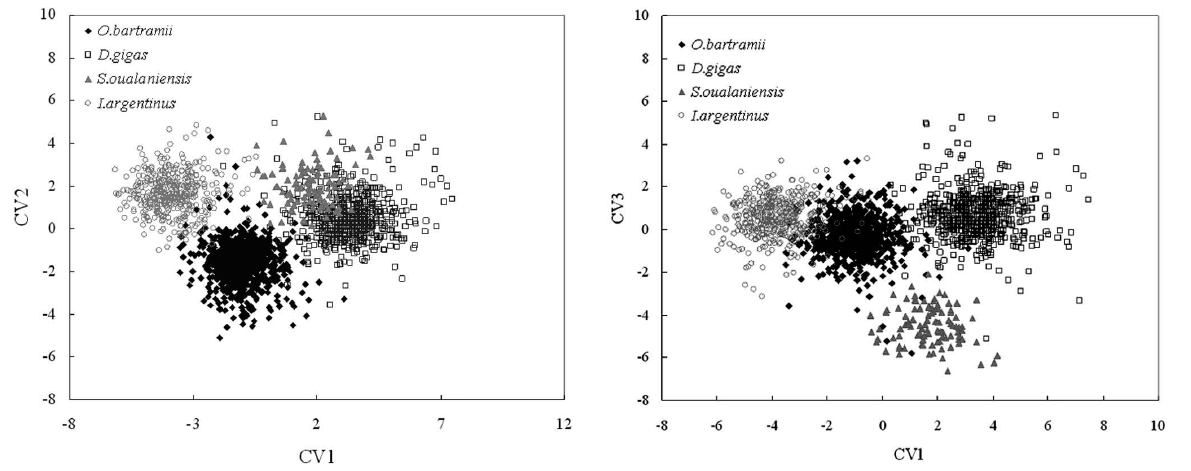
F Ig . 3. – Plot of canonical variables (CV1, CV2 and CV3) of beak morphological variables of O. bartramii , D. gigas , S. oualaniensis and I. argentinus